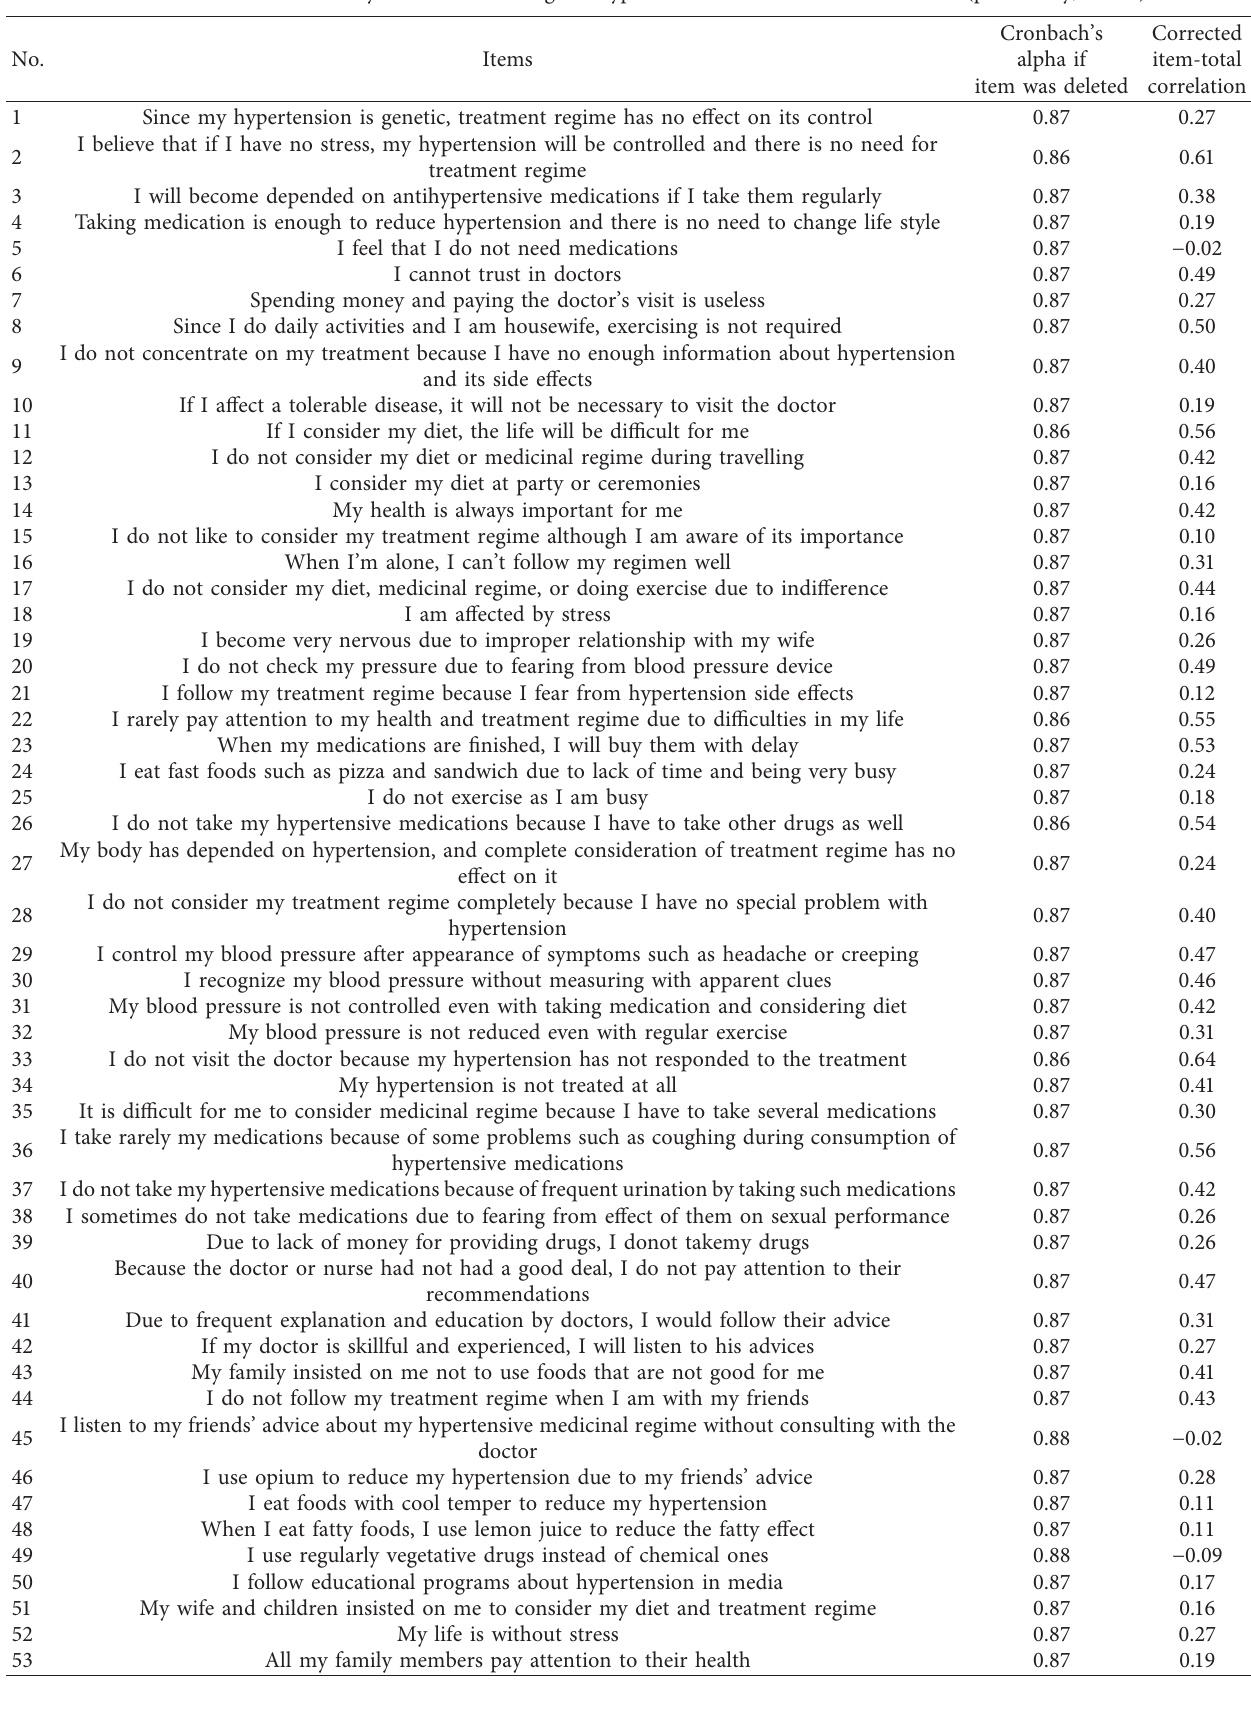
Table 2: Internal consistency of factors affecting the hypertensive treatment adherence scale (pilot study, n � 47). No. Items